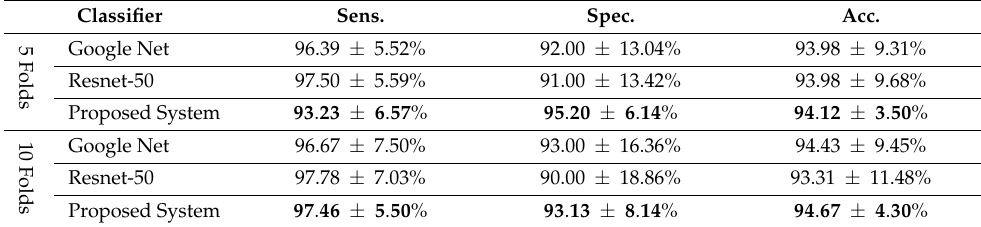
Table 3. Comparison between DL classifiers and the proposed